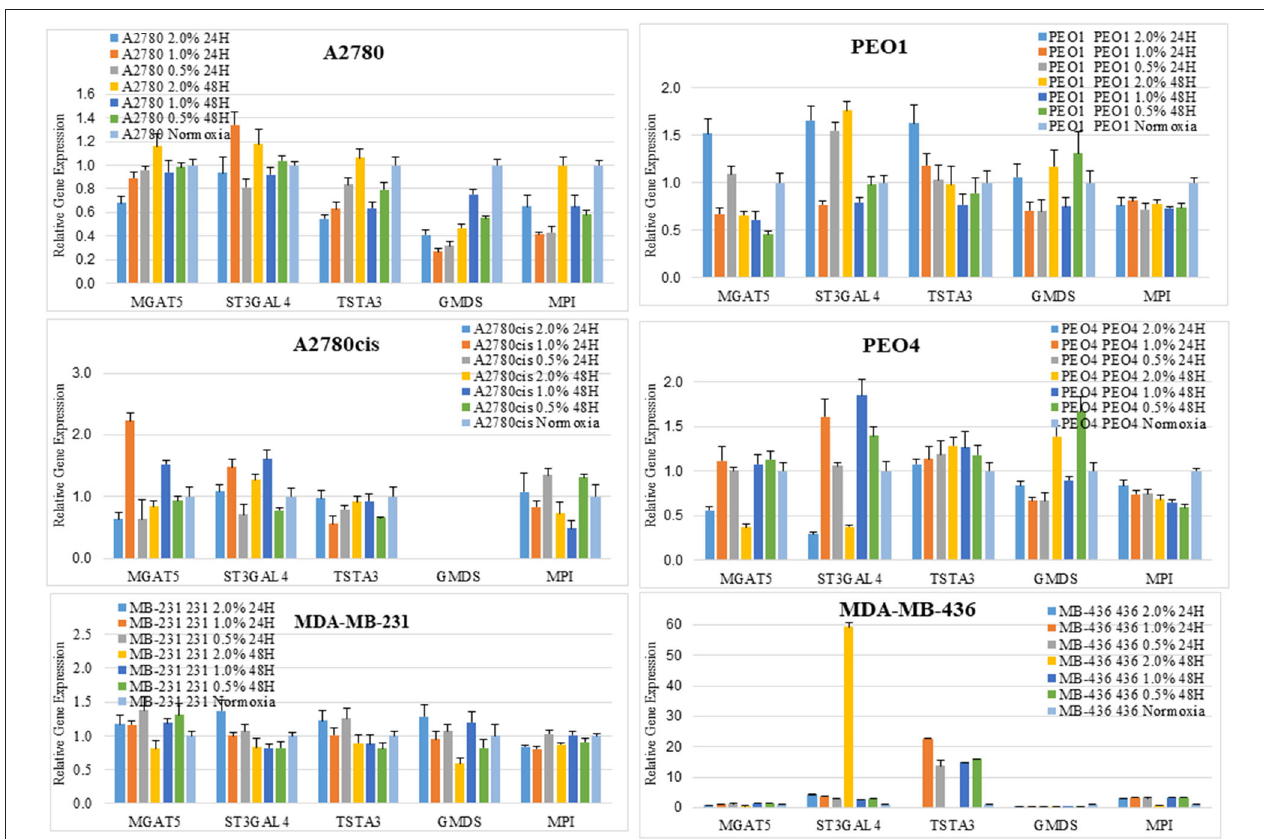
FIGURE 5 | Changes seen in UPLC N- glycan profiles, are associated with the mRNA expression levels of glycosyltransferases. Quantitative RT-PCR gene expression analyses were undertaken for selected glycosyltransferases ( MGAT5 and ST3GAL4 ) and enzymes involved in the sugar nucleotide donor pathway ( MPI , TSTA3, and GMDS ) following the culturing of cells in differential hypoxic conditions (0.5–2% O 2 ) compared to normoxia (21% O 2 ) controls. The relative expression level of each gene was calculated according to the ddCt normalized with TATA-Box Binding Protein (TBP). Each condition was undertaken on one biological replicate ( n = 1) and three technical replicates ( n =